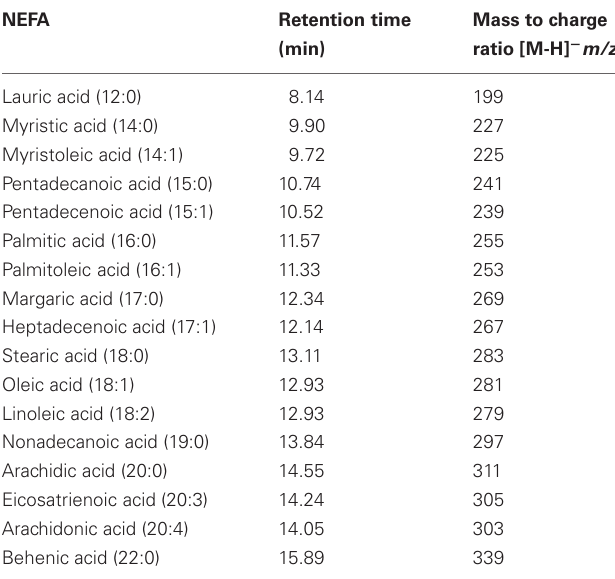
Table 1 | GC–MS analysis of pentafluorobenzyl bromide derivatives of NEFA.